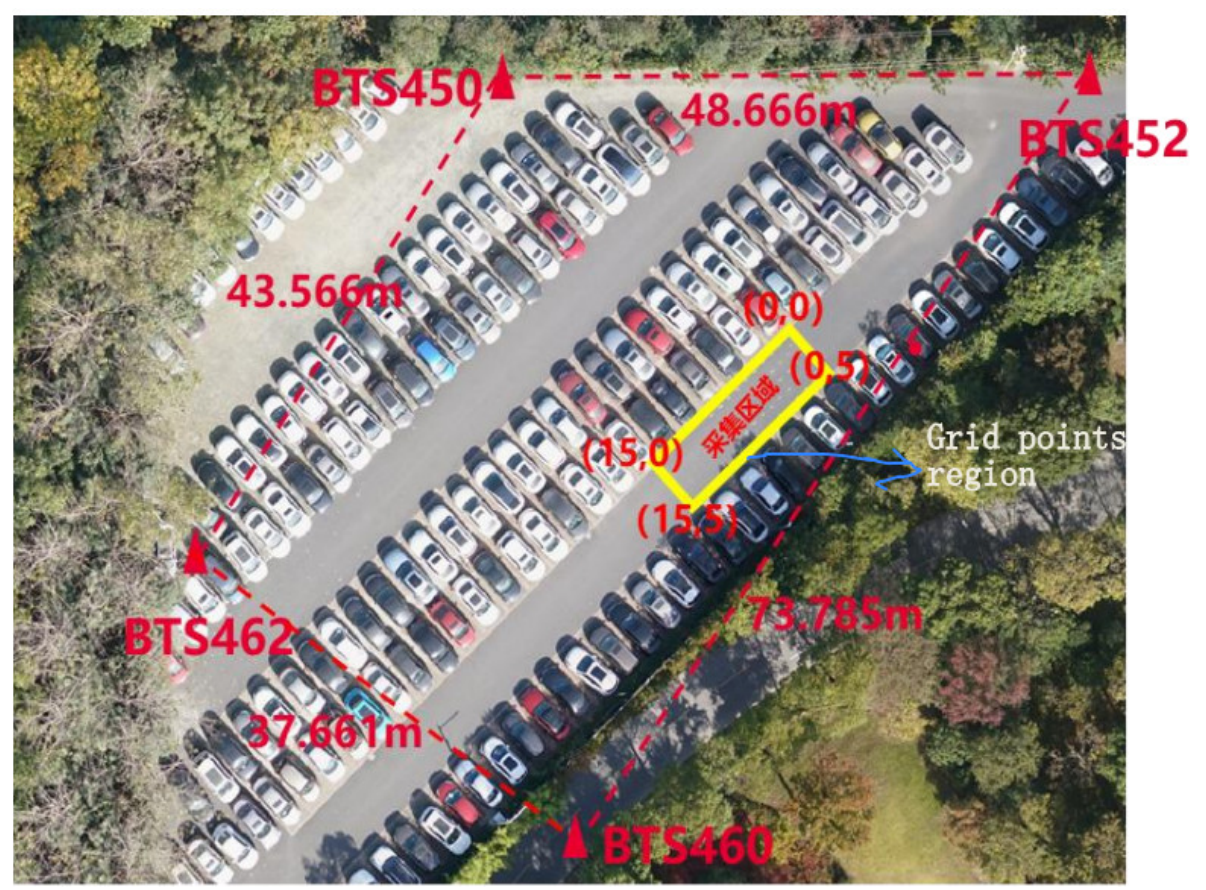
Figure 4. Experimental layout conducted at Huawei company for indoor parking-based CSI fingerprints.